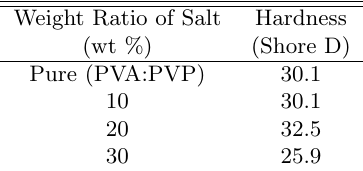
Table 3: Fracture energy values of pure and PVA:PVP polymer blend films reinforced with different weight ra- tios of CdCl 2 · H 2 O